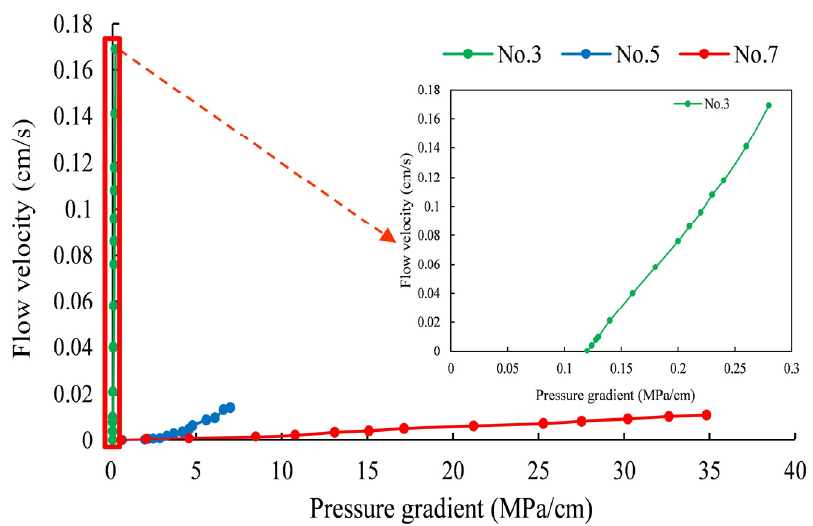
Figure 6. The conventional oil seepage curves of oil flow in migration for the 3 sandstone samples. In single-phase liquid flow, the kickoff pressure gradient and critical pressure gradient are the key parameters to characterize the non-Darcy flow. The kickoff pressure gradient and critical pressure gradient of the oil migration in each sample can be obtained